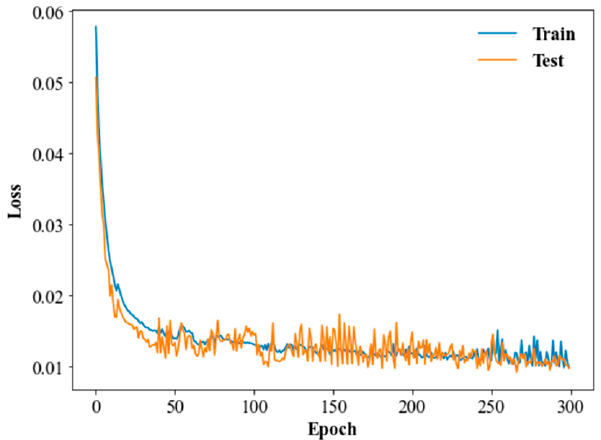
trained model was then validated on the testing set. Figure 10 shows the learning curves of the training and the testing sets for the optimal LSTM architecture. The MAE score, which was used as a loss function for both training and testing sets, decreases to the point of stability as the number of epochs increases. Additionally, there is a small gap between the training and testing loss curves. Meeting these two criteria indicates a good fit for the model.